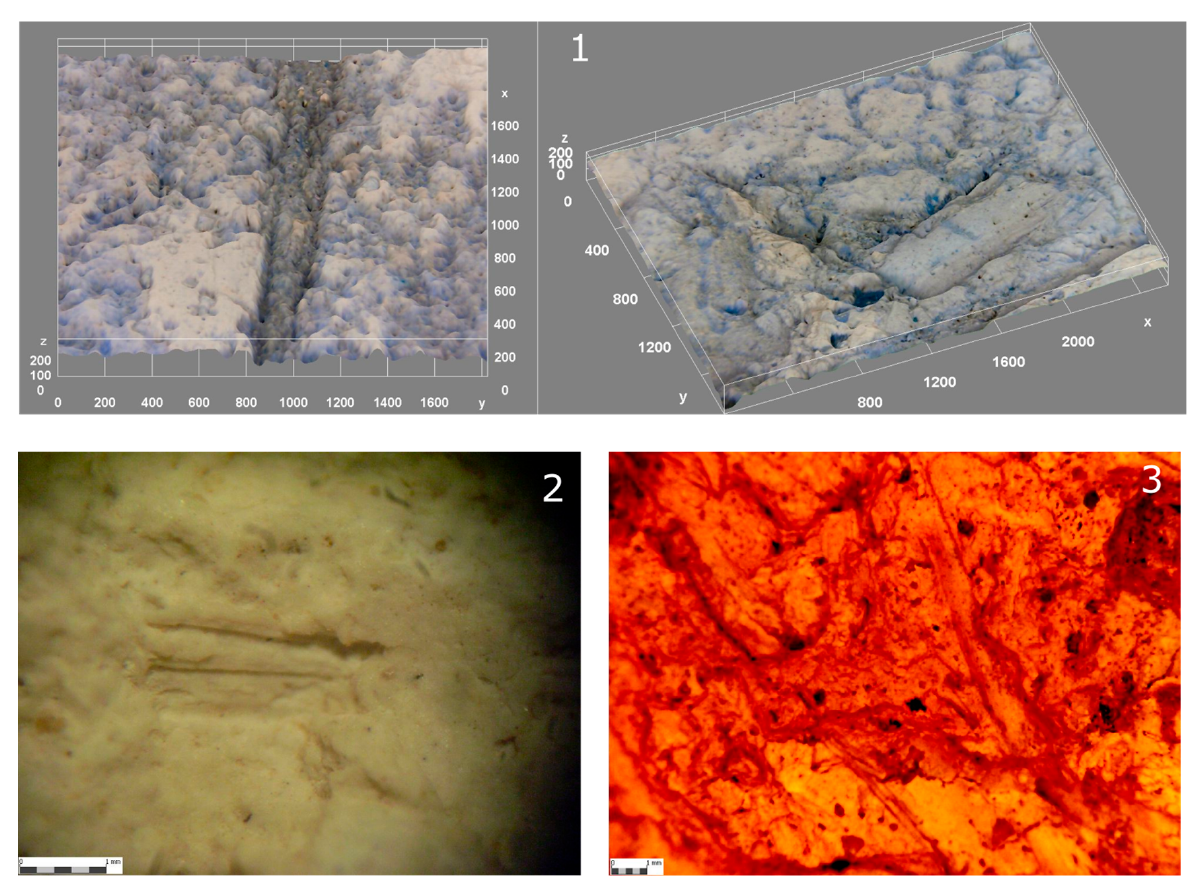
Figure 6. Organic remains in samples NO2 and NO5 (1 mm scale): (1) 3D scan of surface showing fibres (left) and microvertebrates prints (right) in sample NO2, (2) possible dental print in NO5, and (3) infrared picture with several organic prints in sample NO5.